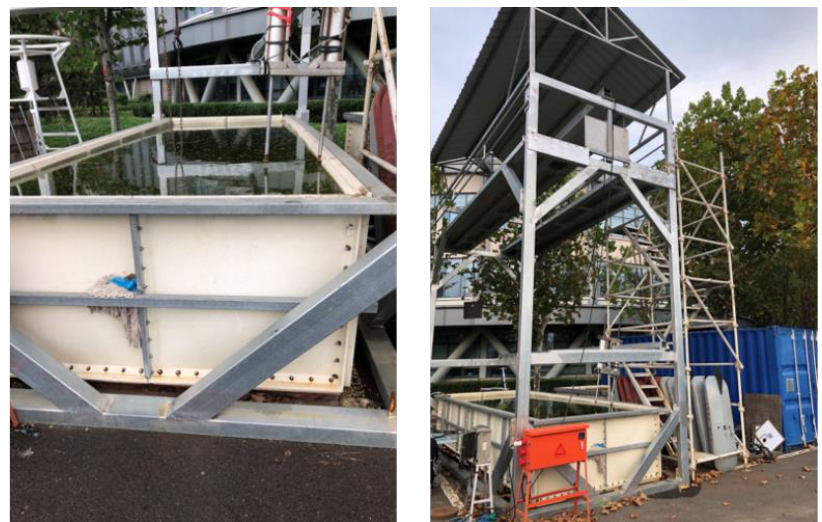
Figure 21. The SALL submerged glider in the tank experiment. Table 10. The dimensions of the tank and experimental platform.